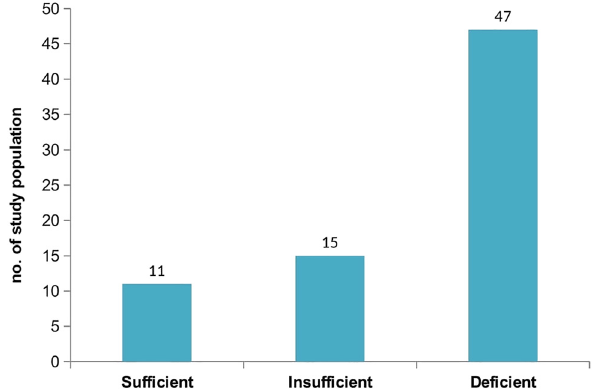
Figure 1: Vitamin D status among the study population.